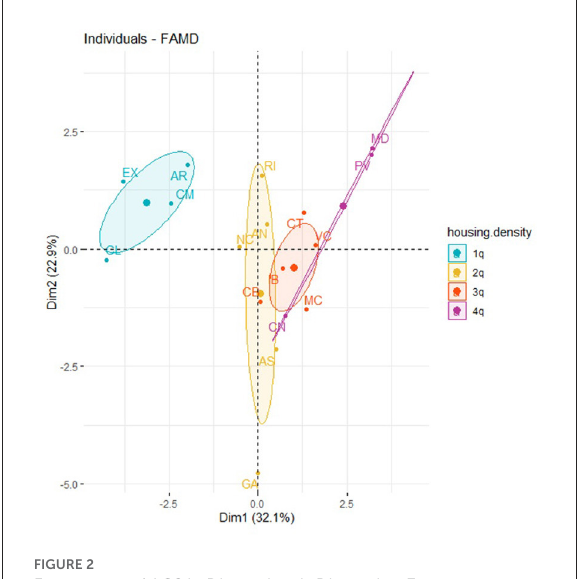
FIGURE2 Factor map of ACS in Dimension 1, Dimension 3, and “housing_density.”